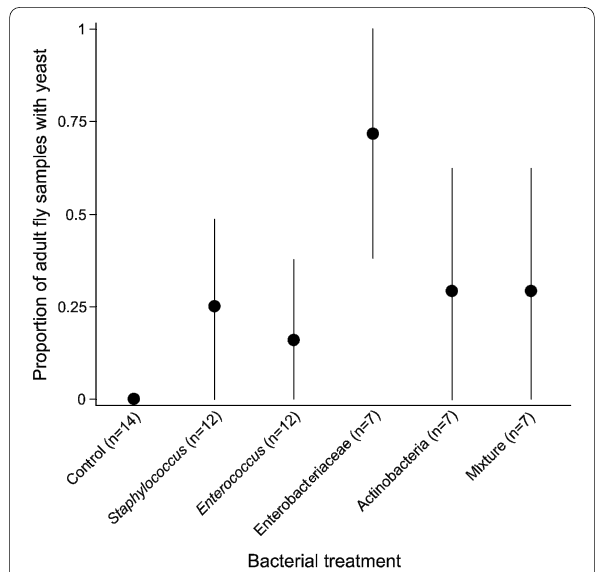
Fig. 1 Transstadial maintenance of Saccharomyces cerevisiae in response to bacterial treatment. Symbols indicate the proportion of groups of freshly emerged adult flies containing yeasts per bacterial treatment (n number of adult groups per bacterial treatment). The = 95% binomial confidence intervals were calculated using normal